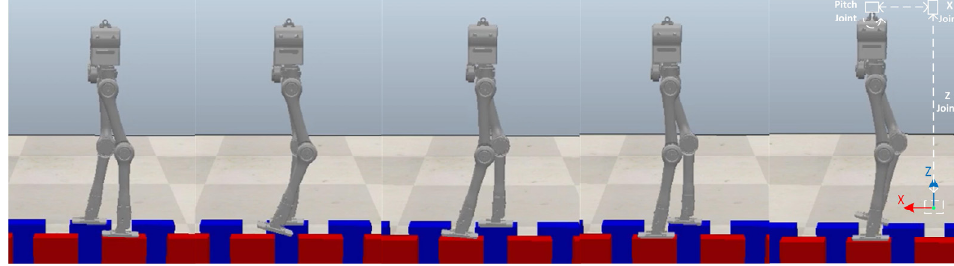
Figure 13. Five key frames of quincuncial piles walking in CoppeliaSim.